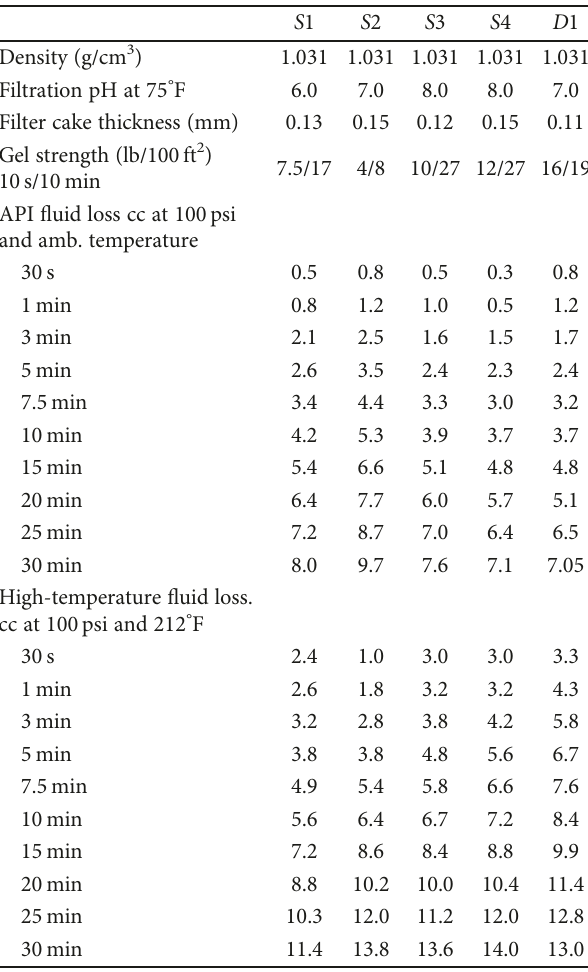
Table 2: Rheological properties of drilling mud samples. Samples